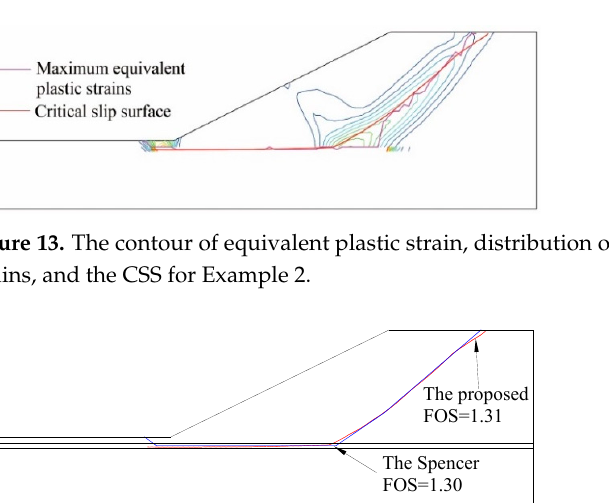
Figure 12. The contours of equivalent plastic strain by the SRM for Example 2. ( a ) F i = 1.15; ( b ) F i = 1.31.